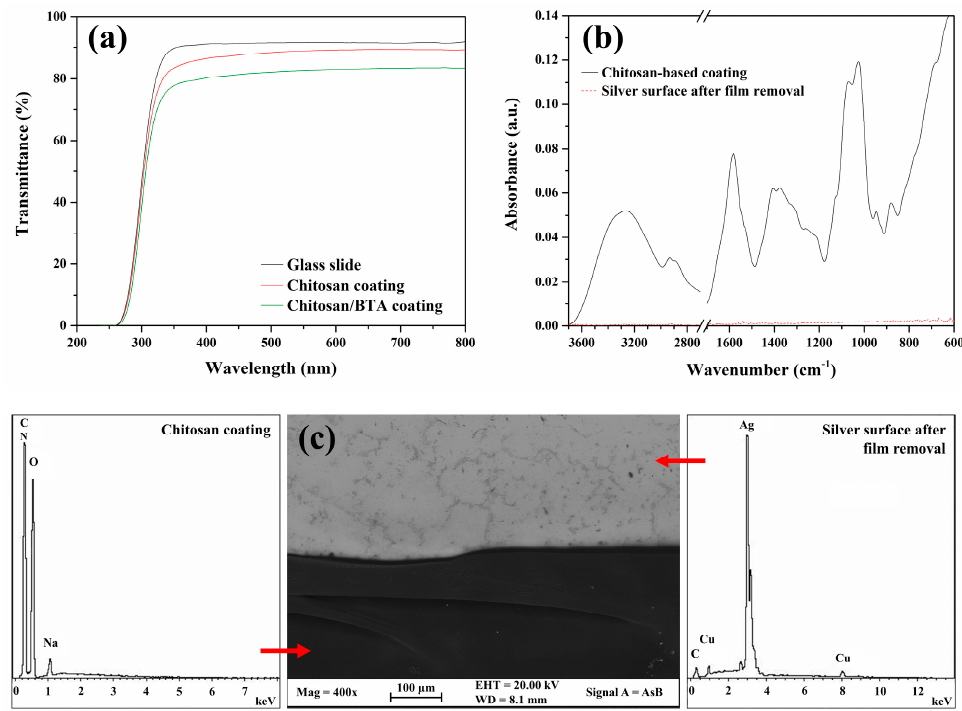
Figure 1. Transparency and removability of chitosan-based coatings. ( a ) UV-Vis transmittance spectra of a glass slide and of chitosan and chitosan/BTA coatings applied on the same glass slide; ( b ) ATR-FTIR spectra acquired on the chitosan coating and on the silver surface after film removal; ( c ) FE-SEM-EDS analyses on the chitosan coating and on the underlying Ag alloy after film removal.